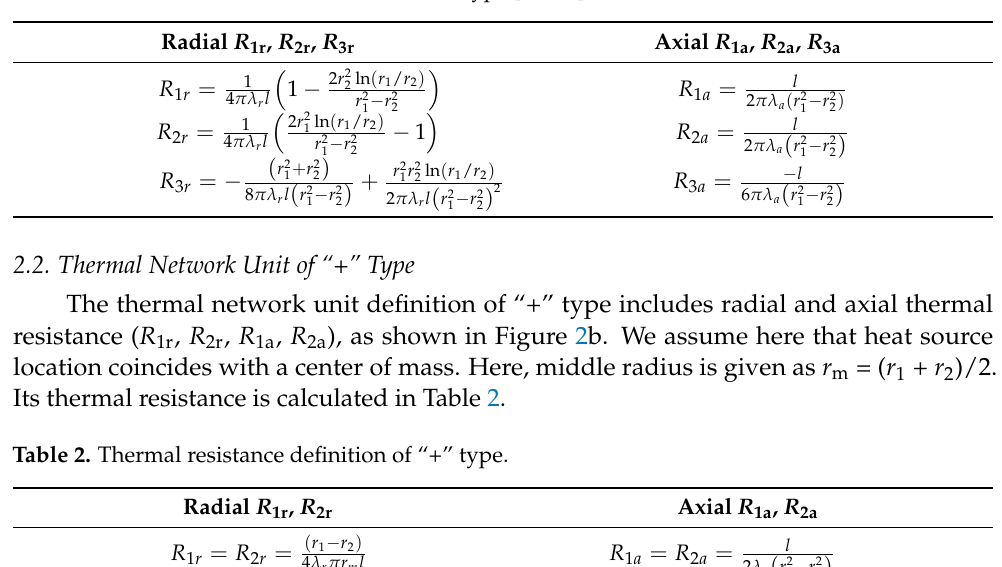
Table 2. Thermal resistance definition of “+” type.